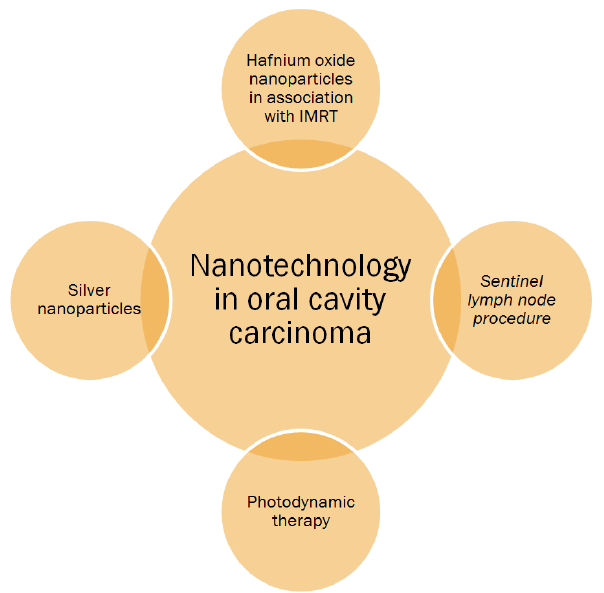
Figure 1. Nanotechnology applications in oral cavity carcinoma.